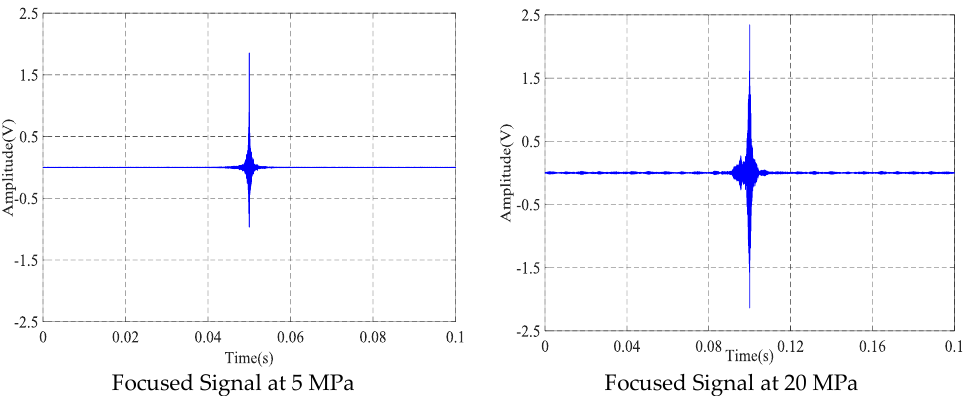
Figure 6. Focused signals based on the time reversal method at different tension levels.